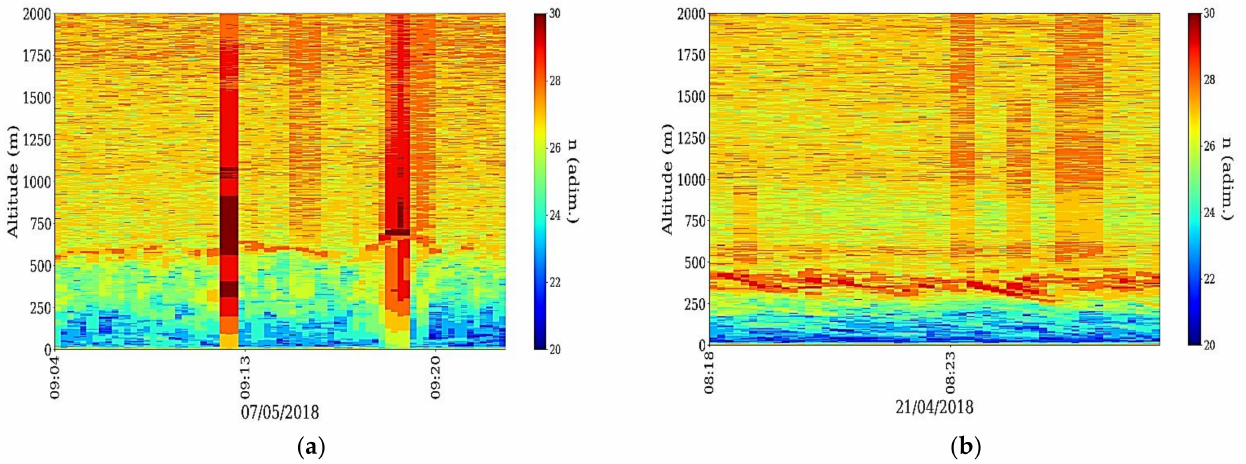
Figure 11. n l timeseries: ( a ) 07 May 2018, 15 s temporal resolution; ( b ) 21 April 2018, 10 s temporal 0